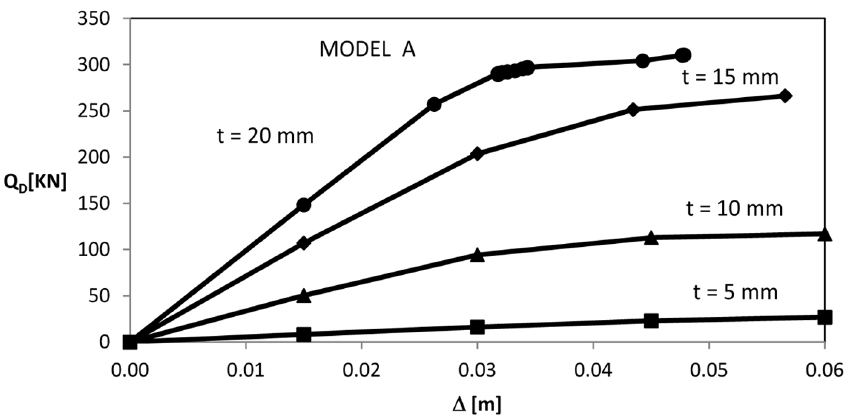
Figure 5. Model A: Pushover curves for different plate thickness.